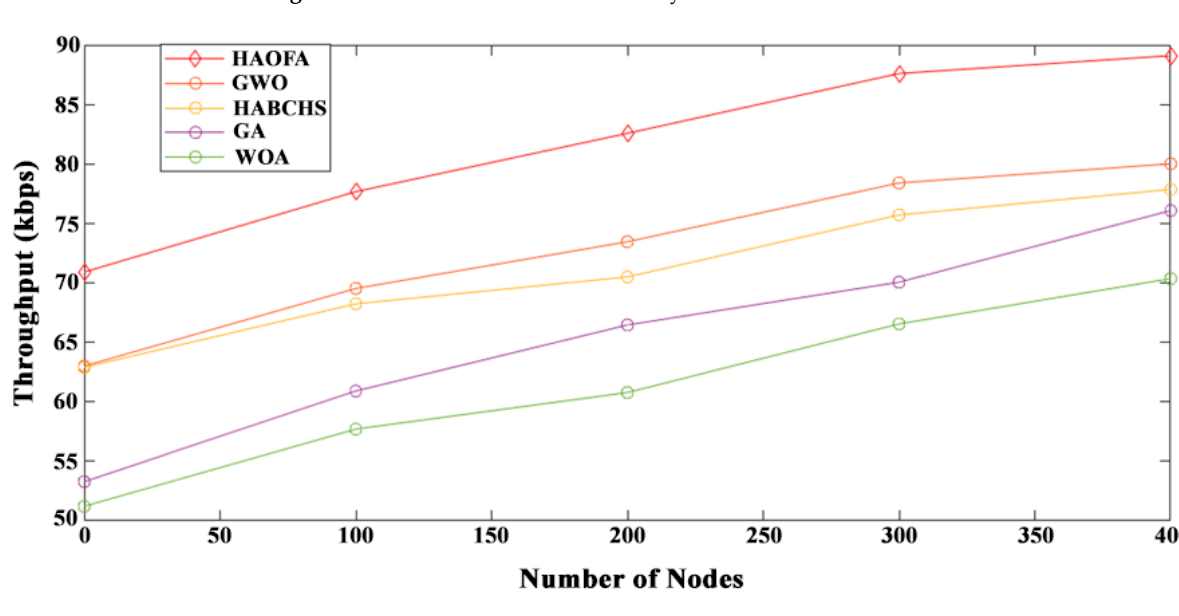
Figure 3. Communication cost. E2E delay.